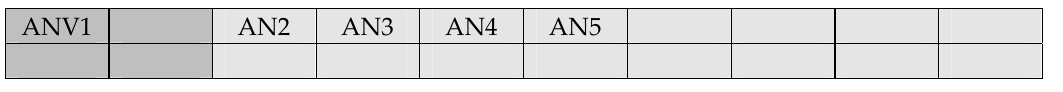
Figure 8. Assigning one seat for each nozzle type in ANC.